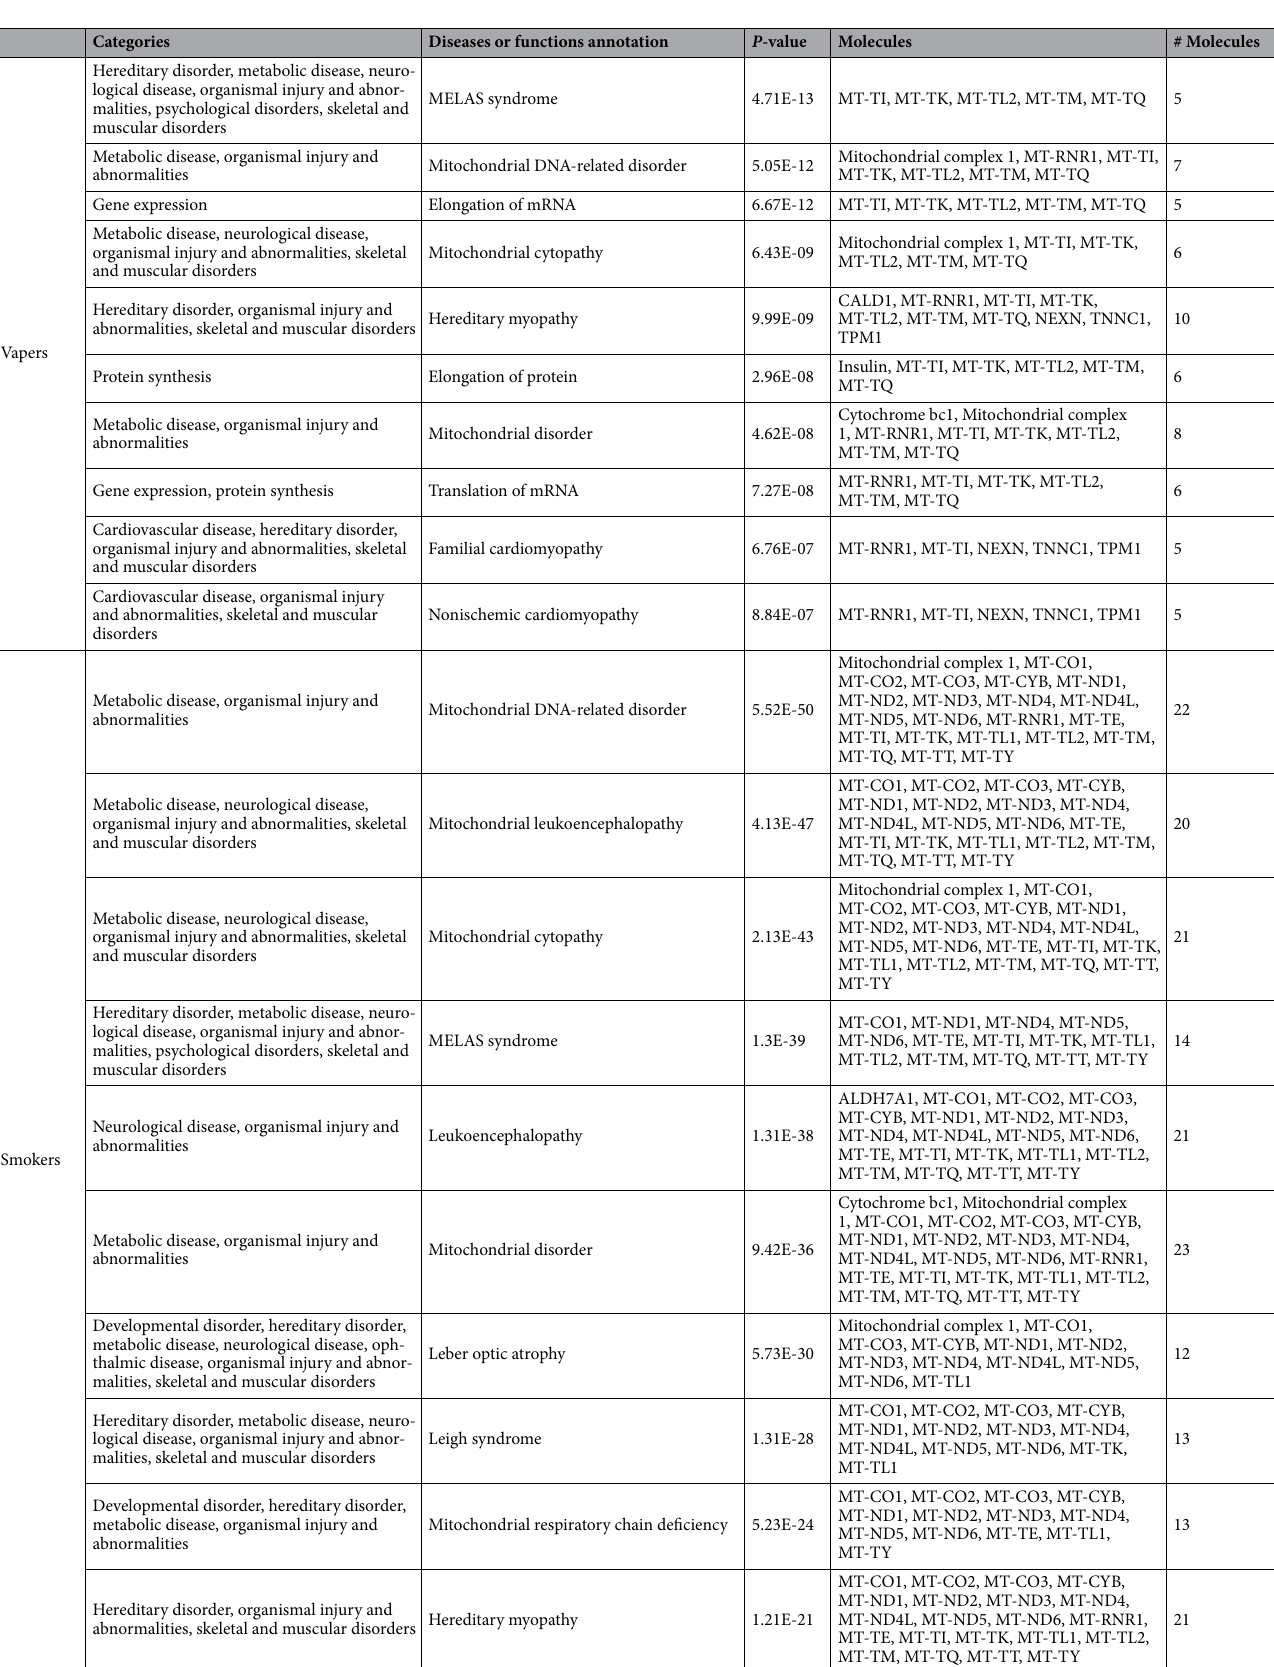
Table 1. Top 10 diseases and functions associated with the top disrupted networks in vapers and smokers, respectively, as illustrated in Fig.